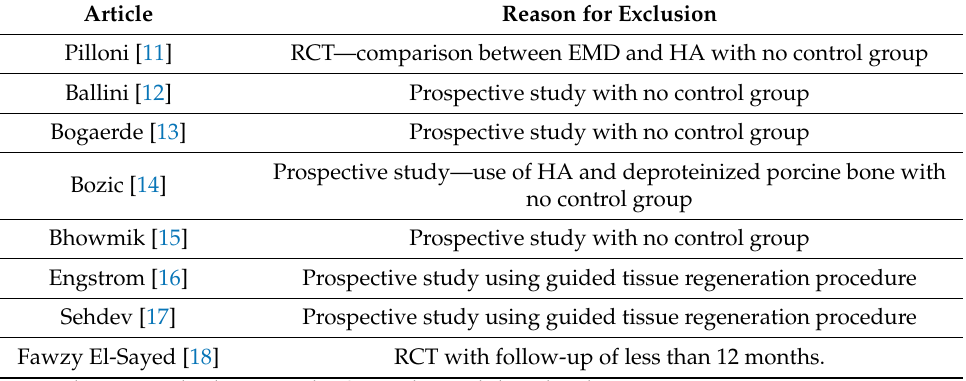
Table 1. Reasons for excluding articles. Article